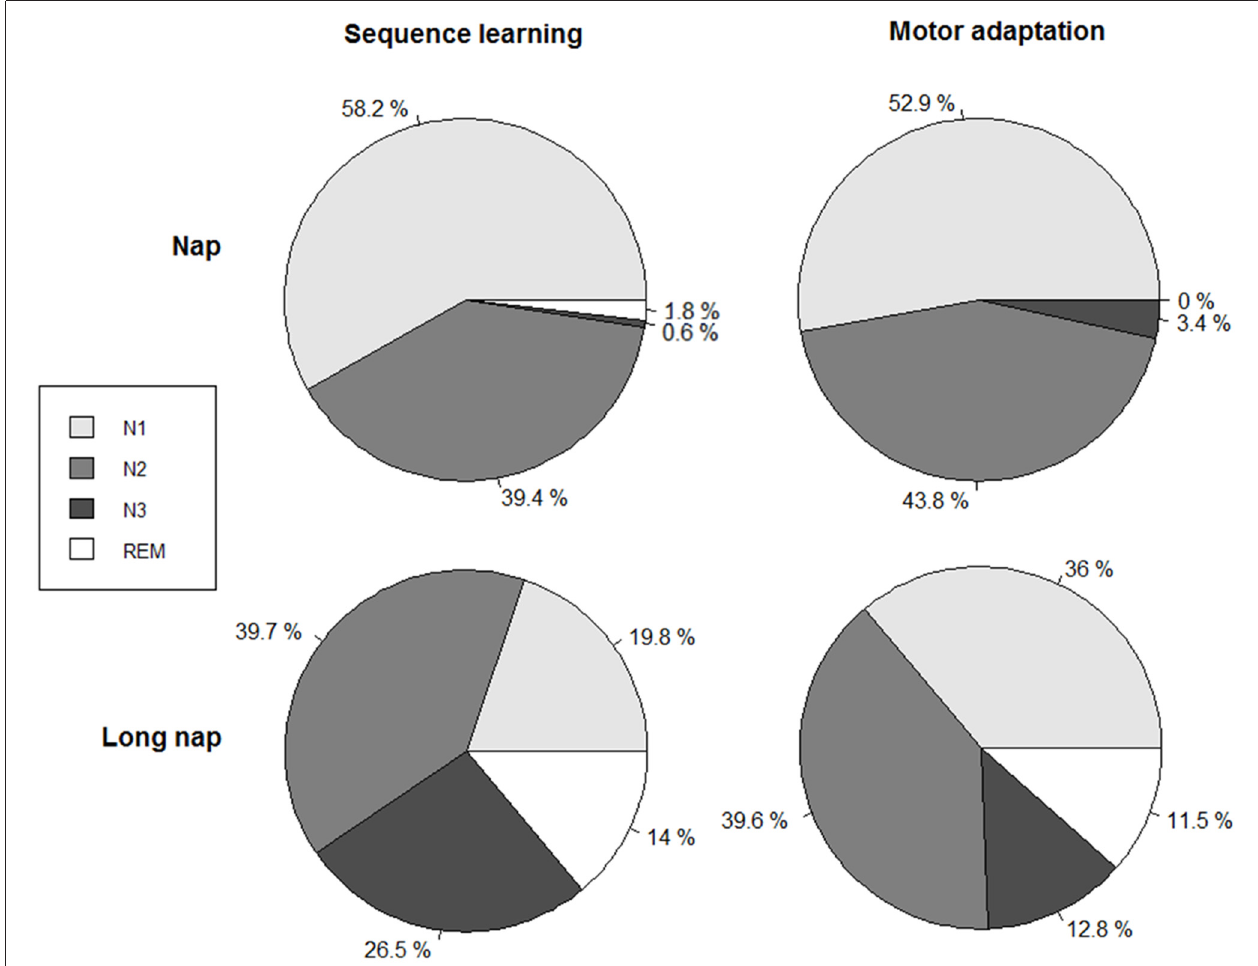
FIGURE 3 | Relative amount of time spent per sleep stage in relation to the total sleep time, for sequence learning (left column) and motor adaptation (right column). Total sleep time (TST) nap (explicit sequence task, SE):16.5 ± 2.9 min, nap (motor adaptation task, MA): 14.9 ± 3.0 min, long nap (SE): 59.7 ± 9.1 min, long nap (MA): 60.4 ± 7.1